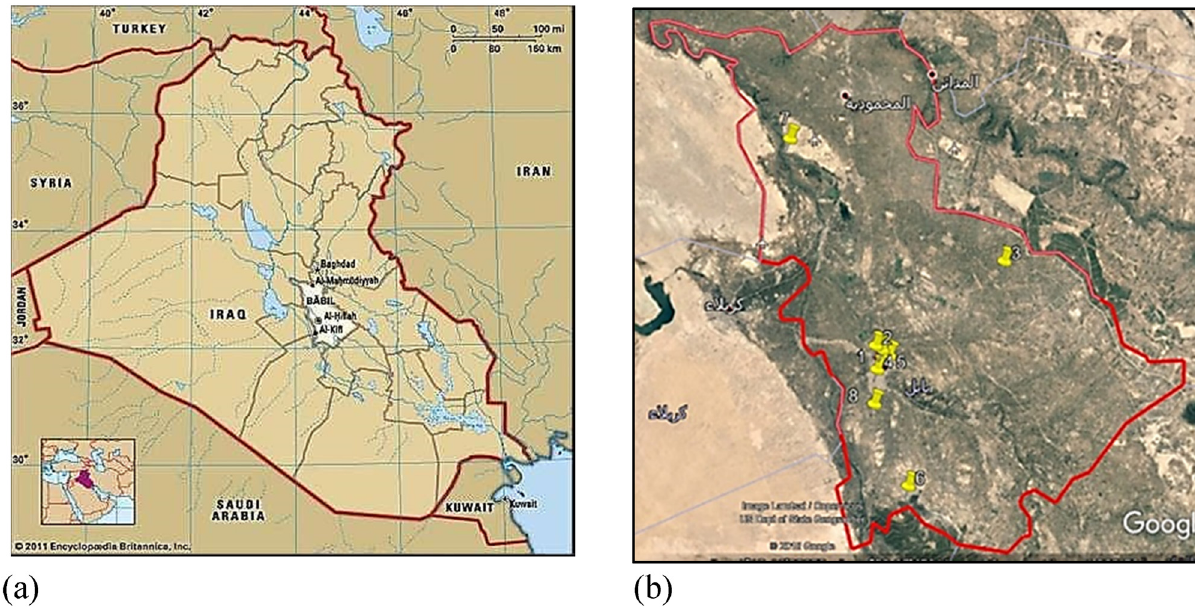
Figure 1: Location of Hilla city: ( a ) the map of Iraq and ( b ) the satellite image of the fi